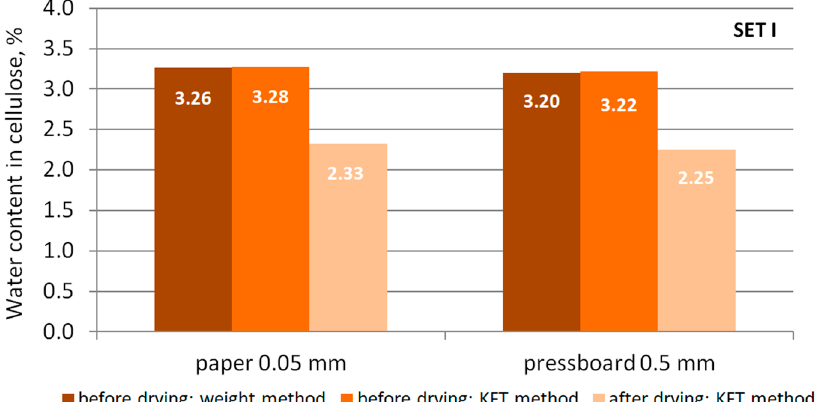
Figure 8. Water content in cellulose materials used in SET I before and after the drying process (70 ° C, 168 h).